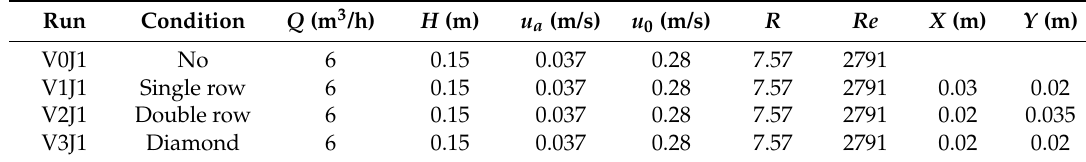
Table 1. Parameters of the experiments.